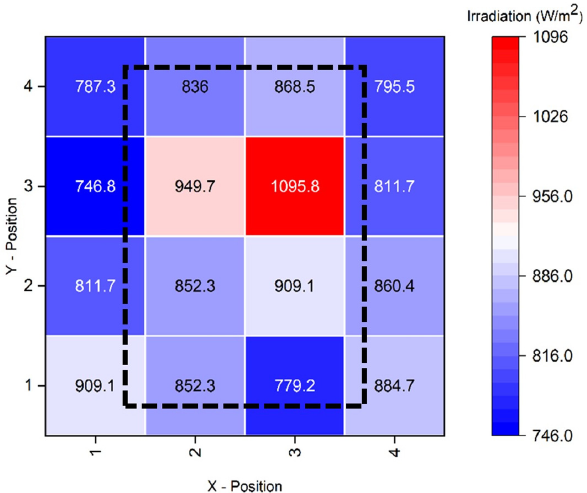
Figure A1. The measured light intensity distribution over an area of 40 cm × 40 cm. The light intensity was measured using a square of 10 cm × 10 cm as a unit. The dash line box indicates that the position of the 10 W PV module during the test. The average light irradiance over the 10 W PV module is 890 W/m 2 when the irradiance intensity at the centre is set at 1000 W/m 2 .